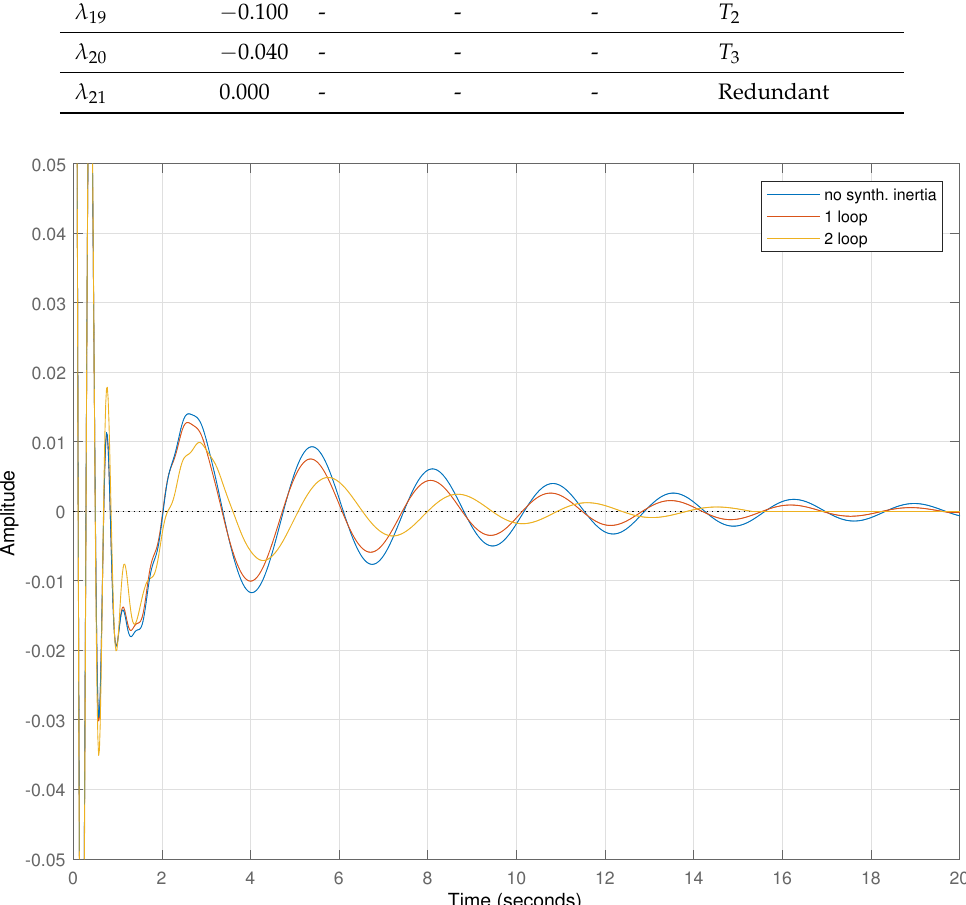
Figure 3. Impulse response of electrical frequency to a change in mechanical torque. Graph shows the deviation from the steady-state